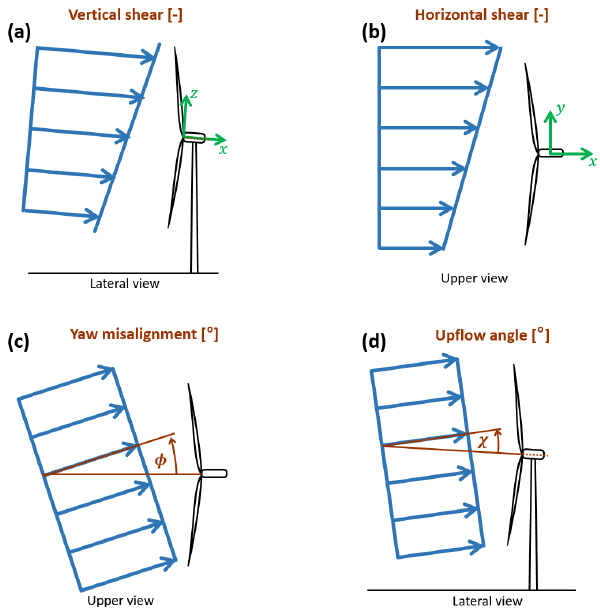
Figure 1. Definition of the four wind states used for parameteriz- ing the wind field over the rotor disk. Vertical shear (a) ; horizontal shear (b) ; yaw misalignment (c) ; upflow angle (d)